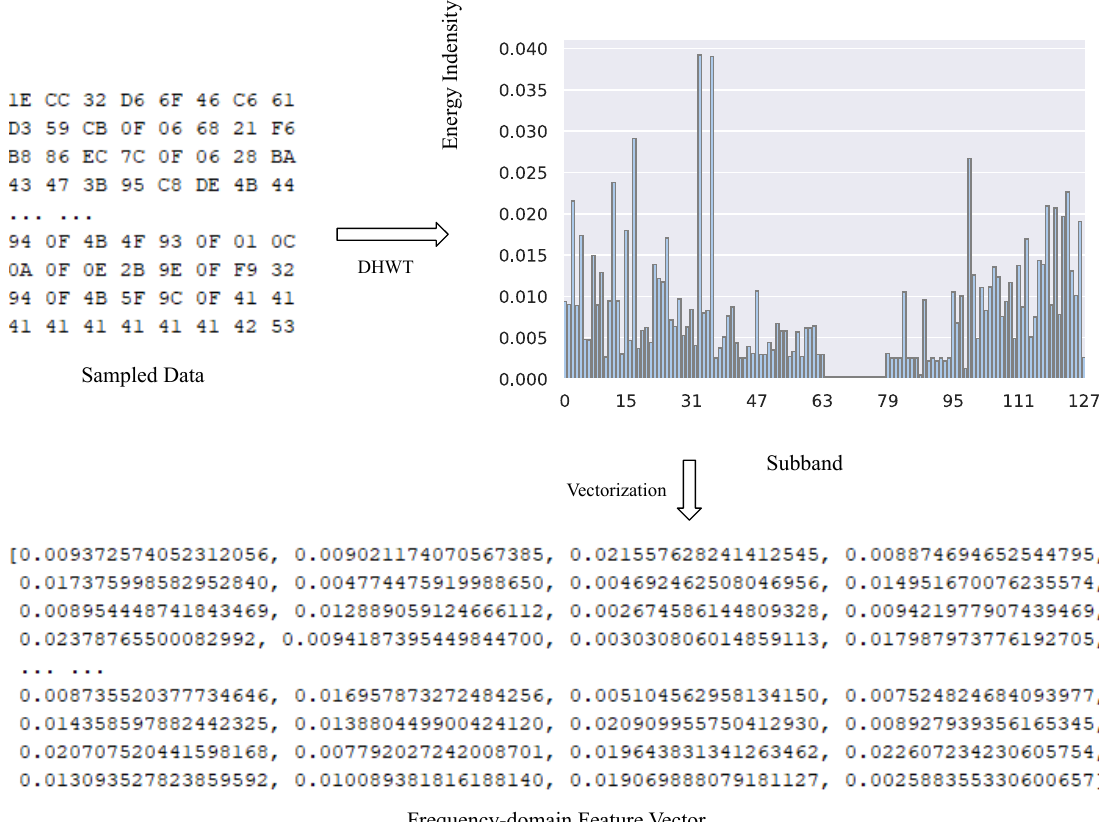
Figure 6. Frequency-domain features extraction from Discrete Haar Wavelet Transform . The y-axis of the histogram represents the cumulative intensity of a given frequency component on the x-axis. We utilize relative values instead of the exact values in the diagram. Then we convert the energy spectrum into tabular data and acquire a 128- dimension vector which represents the frequency-domain characteristic. Moreover, through frequency-domain analysis, the inference from noise bytes can be largely reduced, and the signal-to-noise ratio is promisingly